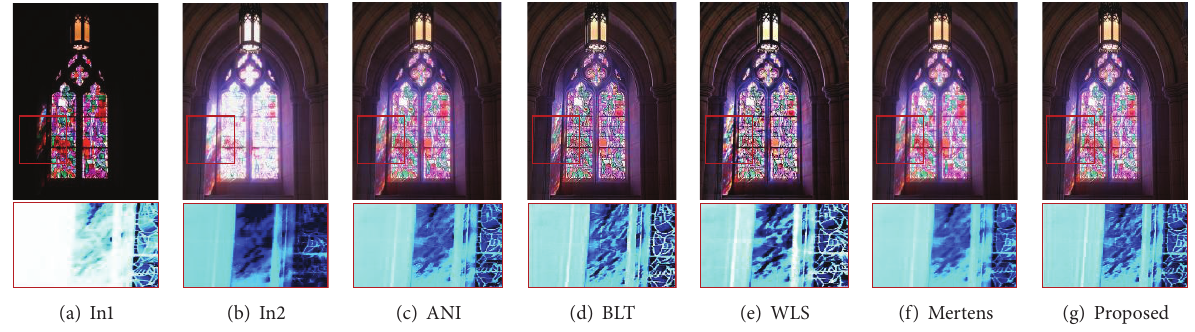
Figure 6: Color-coded map comparison (dark blue color indicates overexposed region and pure white indicates underexposed region). Comparison results to other classic edge preserving and exposure fusion techniques. (a) Source exposure 1; (b) source exposure 2; (c) anisotropic filter [9]; (d) bilateral filter [11]; (e) weighted least square filter [14]; (f) Mertens [4]; (g) results of our new exposure fusion method based on guided filter. Note that our method yields enhanced texture and edge features. Input image sequence courtesy of Tom